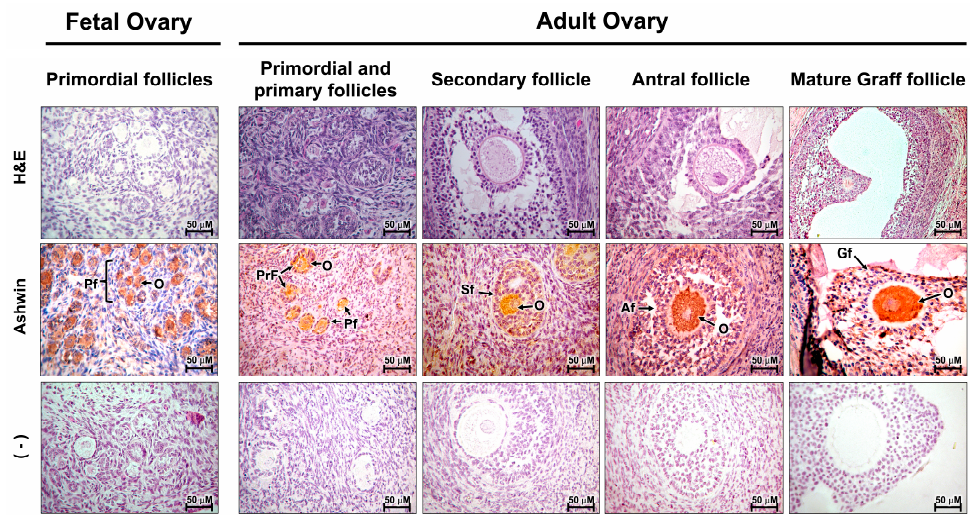
Figure 3. Expression of the ashwin protein in fetal and adult bovine ovary tissue. Representative immunohistochemical staining of bovine ovary sections showing ashwin immunoreactivity (brown) in the oocyte cytoplasm of primordial (Pf), primary (PrF), secondary (Sf), antral (Af), and Graff (Gf) follicles. (–) Negative control showing no positive staining. H&E, hematoxylin and eosin. The images were acquired at 40× magnification.